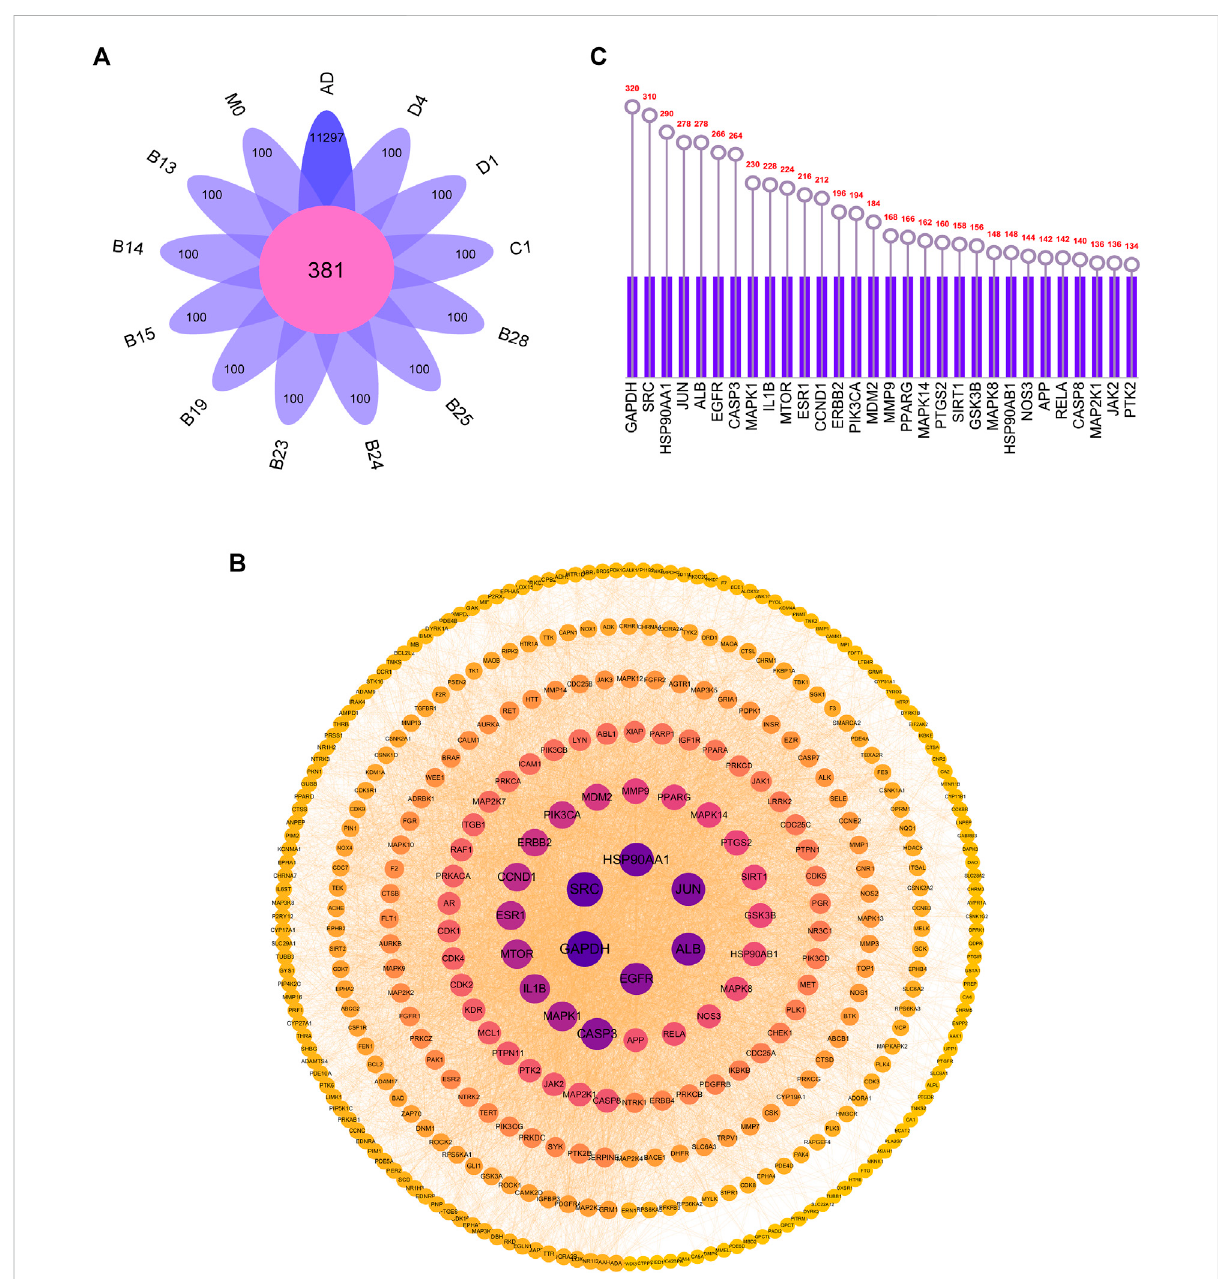
FIGURE 5 (A) Overlapping targets of AD-related targets and 12 metabolites targets (B) PPI network diagram (C) The top 30 core targets for arctigenin treat